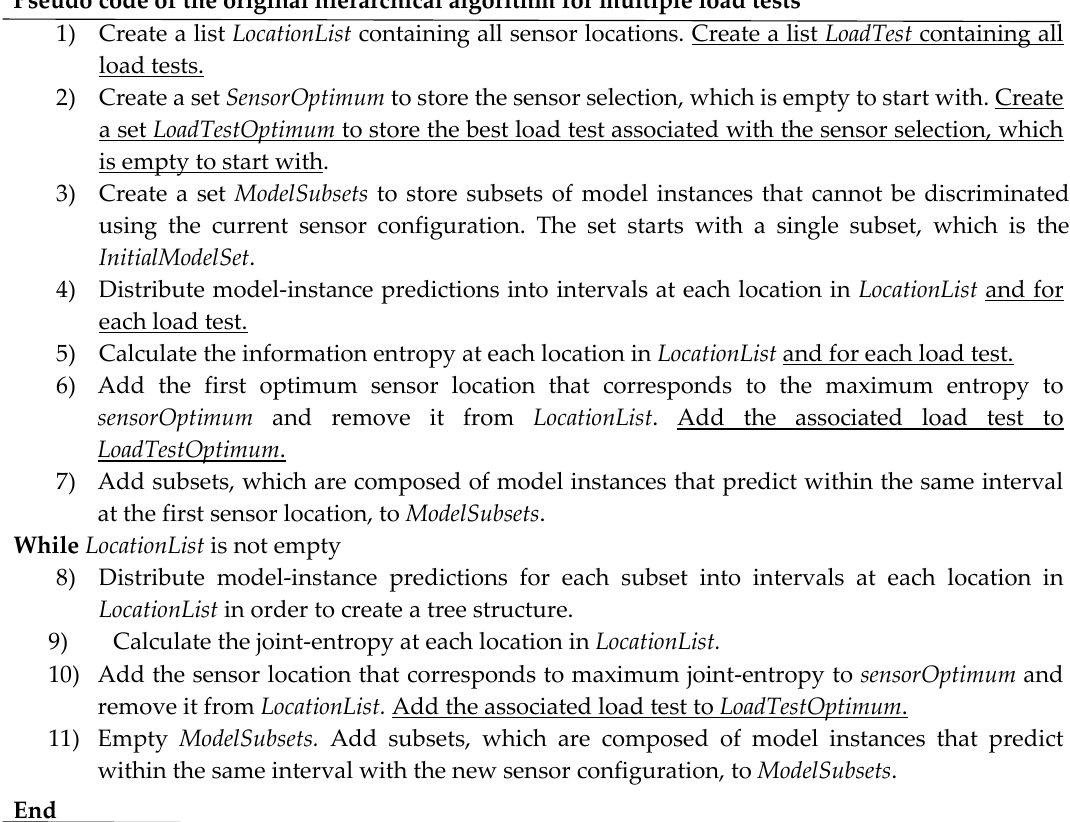
Figure 4. Pseudo-code of the original hierarchical algorithm for multiple load tests within the first modification.